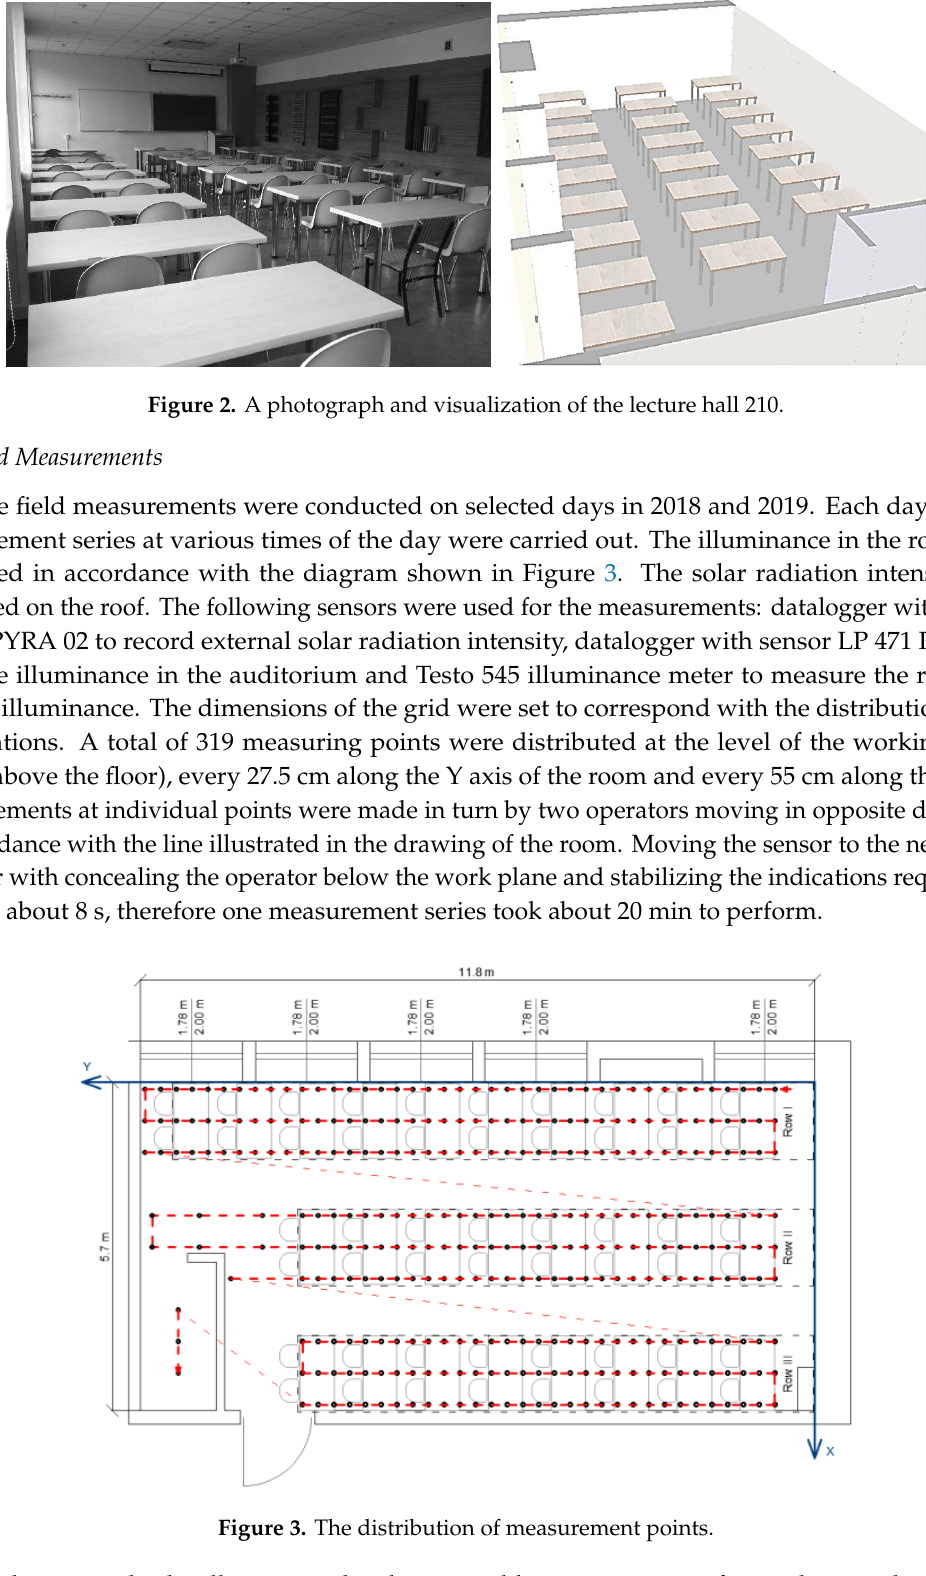
Figure 3. The distribution of measurement points. 126